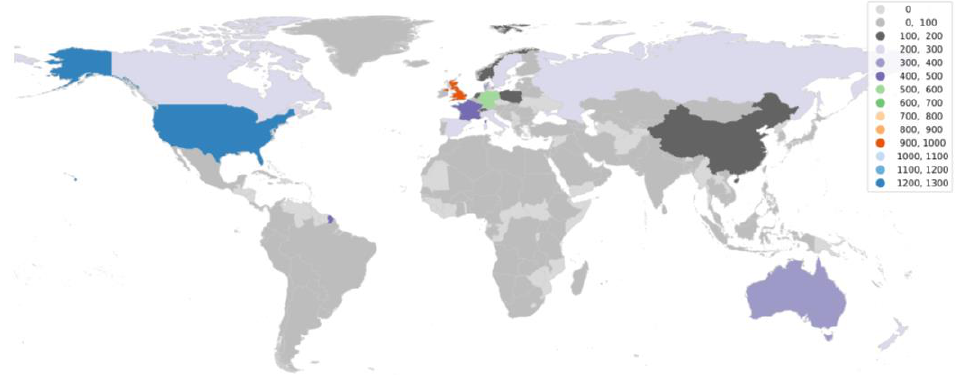
Figure 4. World map showing aDNA non-human-based research publications around the globe.